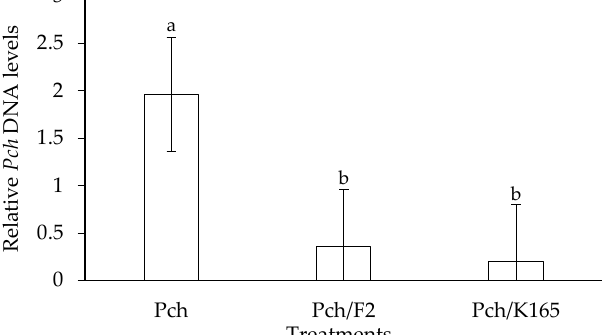
Figure 2. Relative quantification of Phaeomoniella chlamydospora DNA levels in the Paenibacillus alvei K165 (Pch/K165), Fusarium oxysporum F2 (Pch/F2) and control (Pch) treated grapevines. Fungal DNA levels were estimated by qPCR using total DNA isolated from grapevines at 90 dpi. The columns represent the means of three biological repeats ( n = 3) (with eight grapevines per treatment and repeat). Columns with different letters are significantly different ( p < 0.05) according to LSD test. The vertical bars indicate the standard difference value.